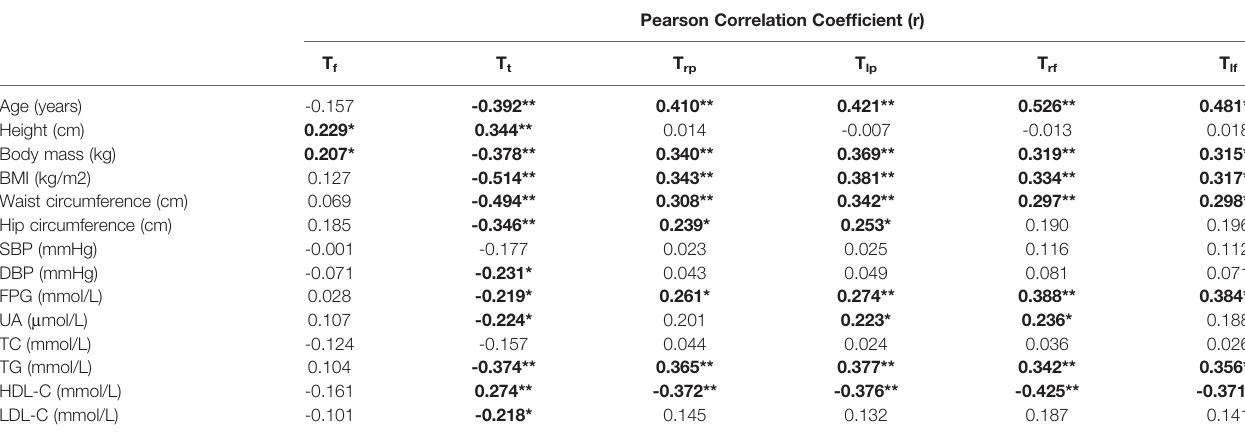
TABLE 3 | Pearson correlation analysis between T mean of each ROI and measurement data & laboratory data in female groups.